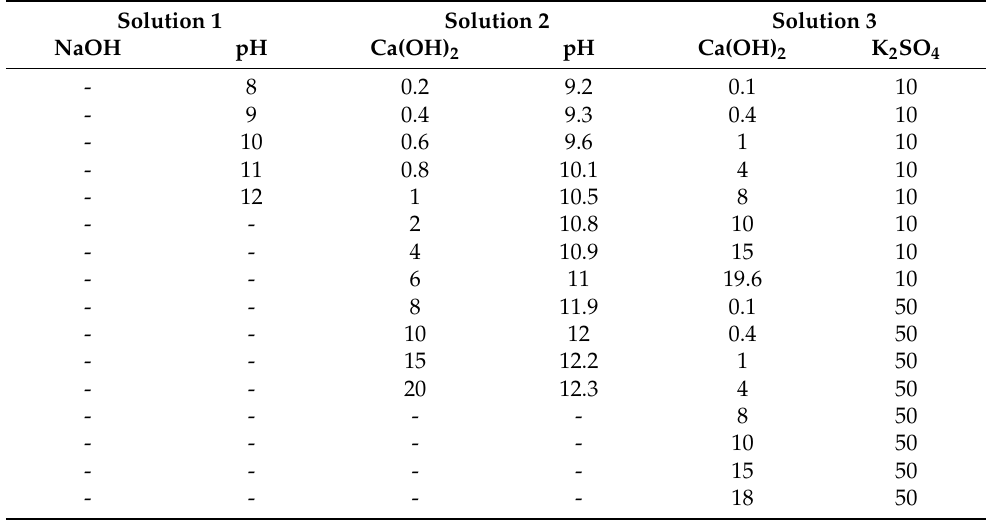
Table 3. Mix proportions of paste the composition of the simulated solutions (mmol/L). Solution 1